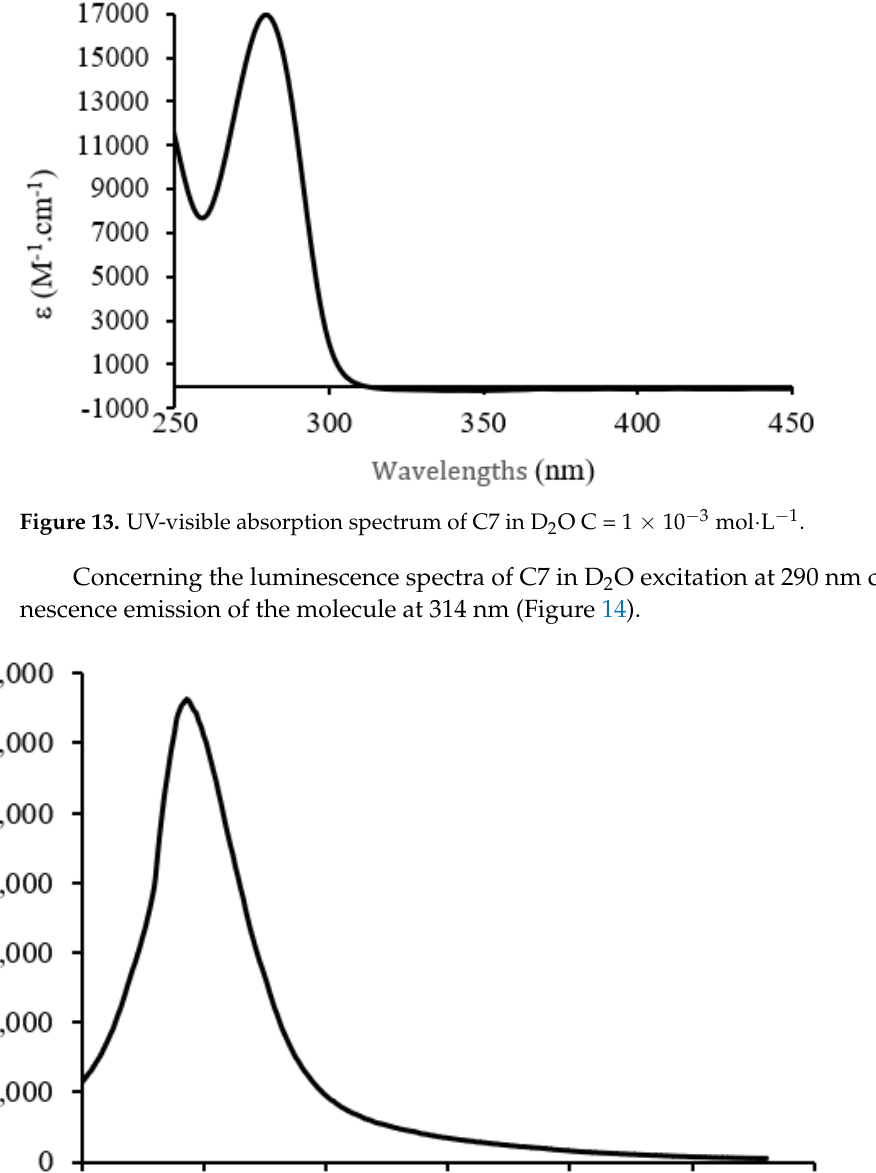
× 10 − 5 mol · L − 1 2 O. C = 5